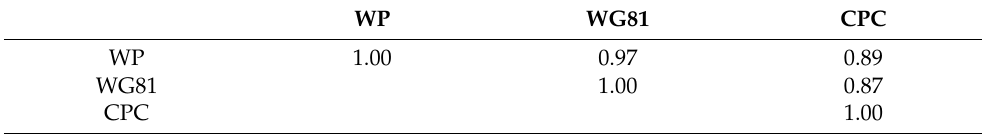
Table 3. TCC between the WP